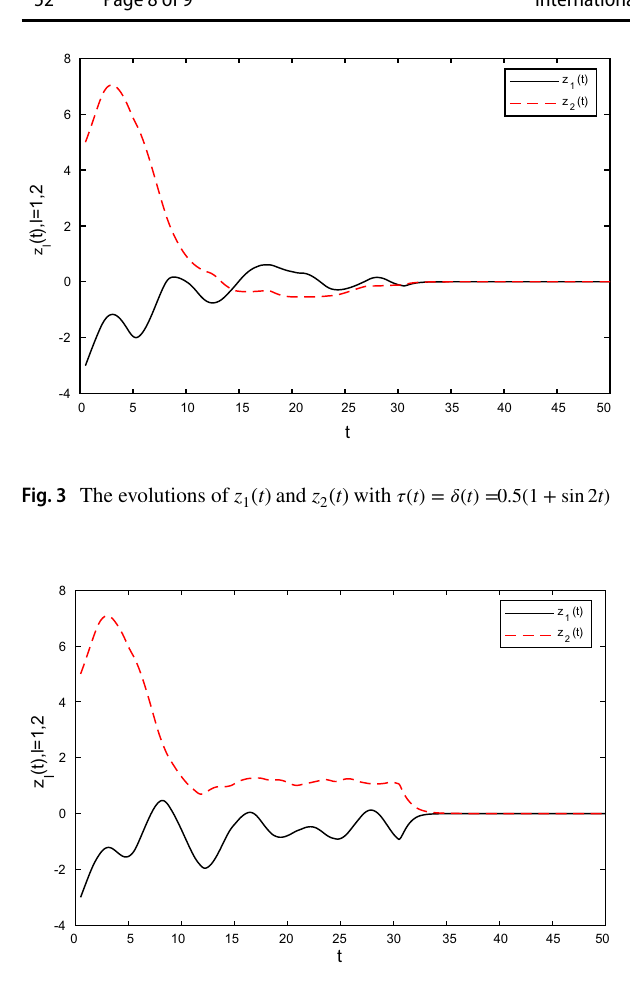
Fig. 4 The evolutions of z 1 ( t ) and z 2 ( t ) with 𝜏 ( t ) = 0.5cos 2 ( 2 t ) , 𝛿 ( t ) = 0.5sin 2 ( 2 t